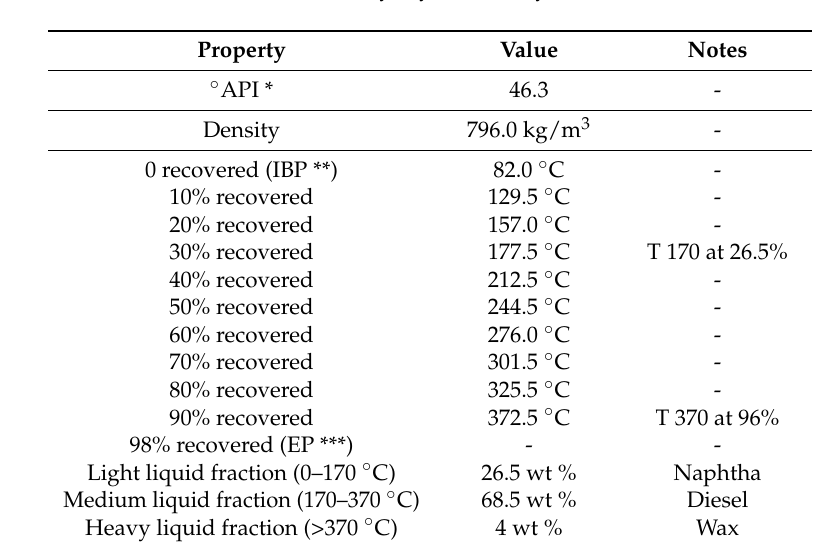
Table 1. Pyrolysis oil analysis.